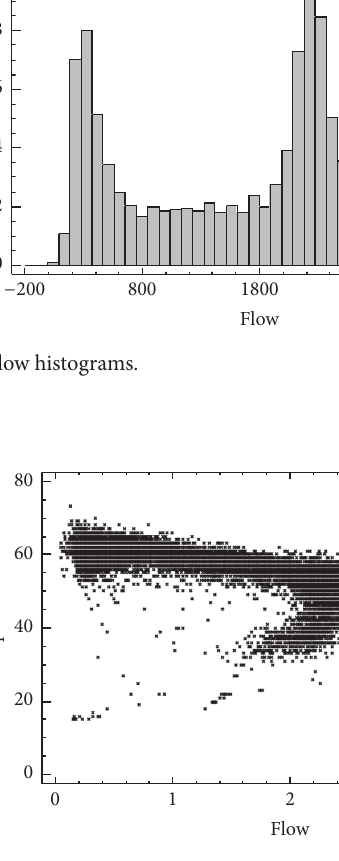
Figure 4: Average instantaneous speed [km/h] against hourly flow [veh/h].